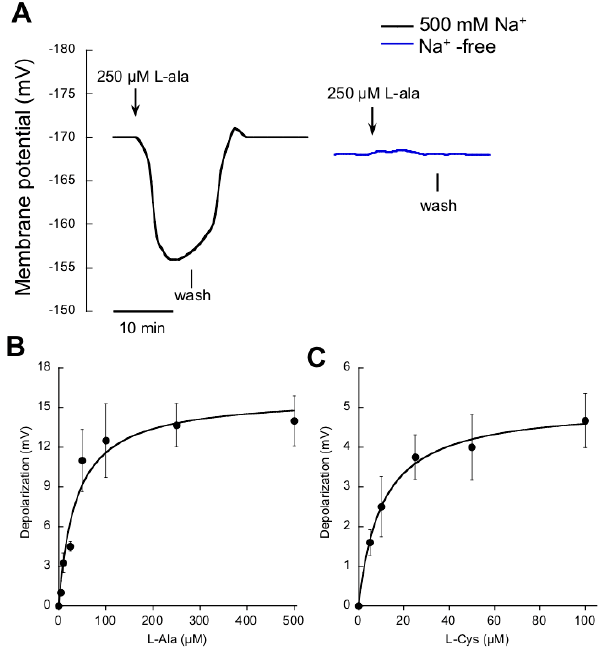
Figure 3. Effect of the addition of micromolar amino acid concentrations on the membrane potential of P. oceanica mesophyll leaf cells. ( A ) Membrane potential changes after the addition of 250 μ M L -ala (downward arrows) in ASW containing 500 mM NaCl (black trace) or in Na + -free ASW (blue trace); vertical lines show the onset of the wash. Mean values of the membrane potential depolarizations induced by increasing concentrations of L -ala ( B ) or L -cys ( C ). Data were fitted to the Michaelis-Menten equation and kinetics parameters are shown in Table 2. Values are the means ± SD of five independent replicates.